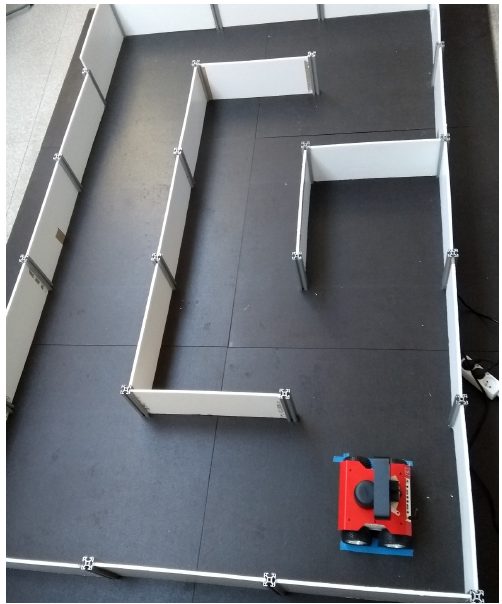
Figure 9. Husarion ROSbot in the